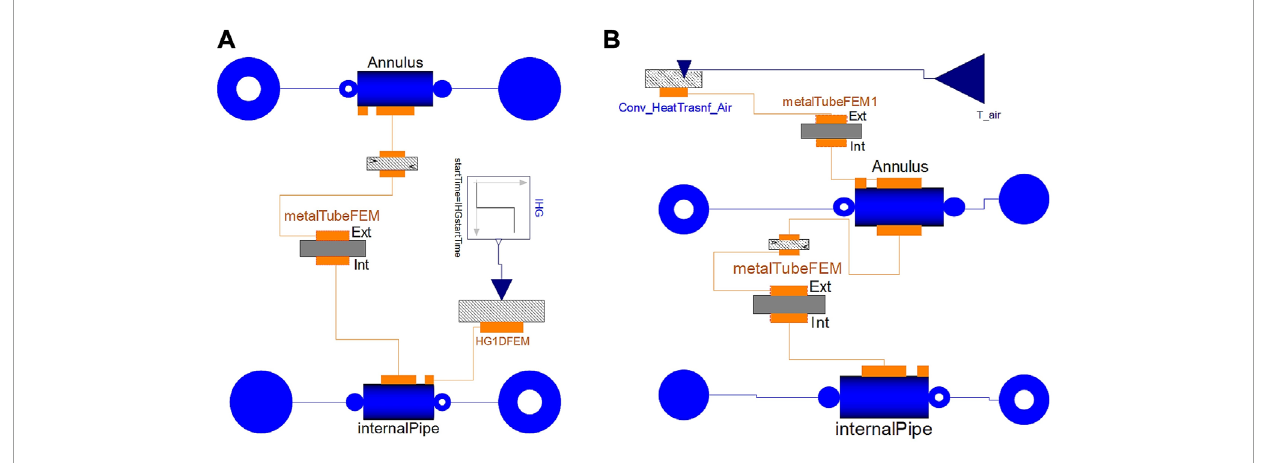
FIGURE 5 (A) HX preliminary adiabatic model and (B) HX model with heat losses inclusion.